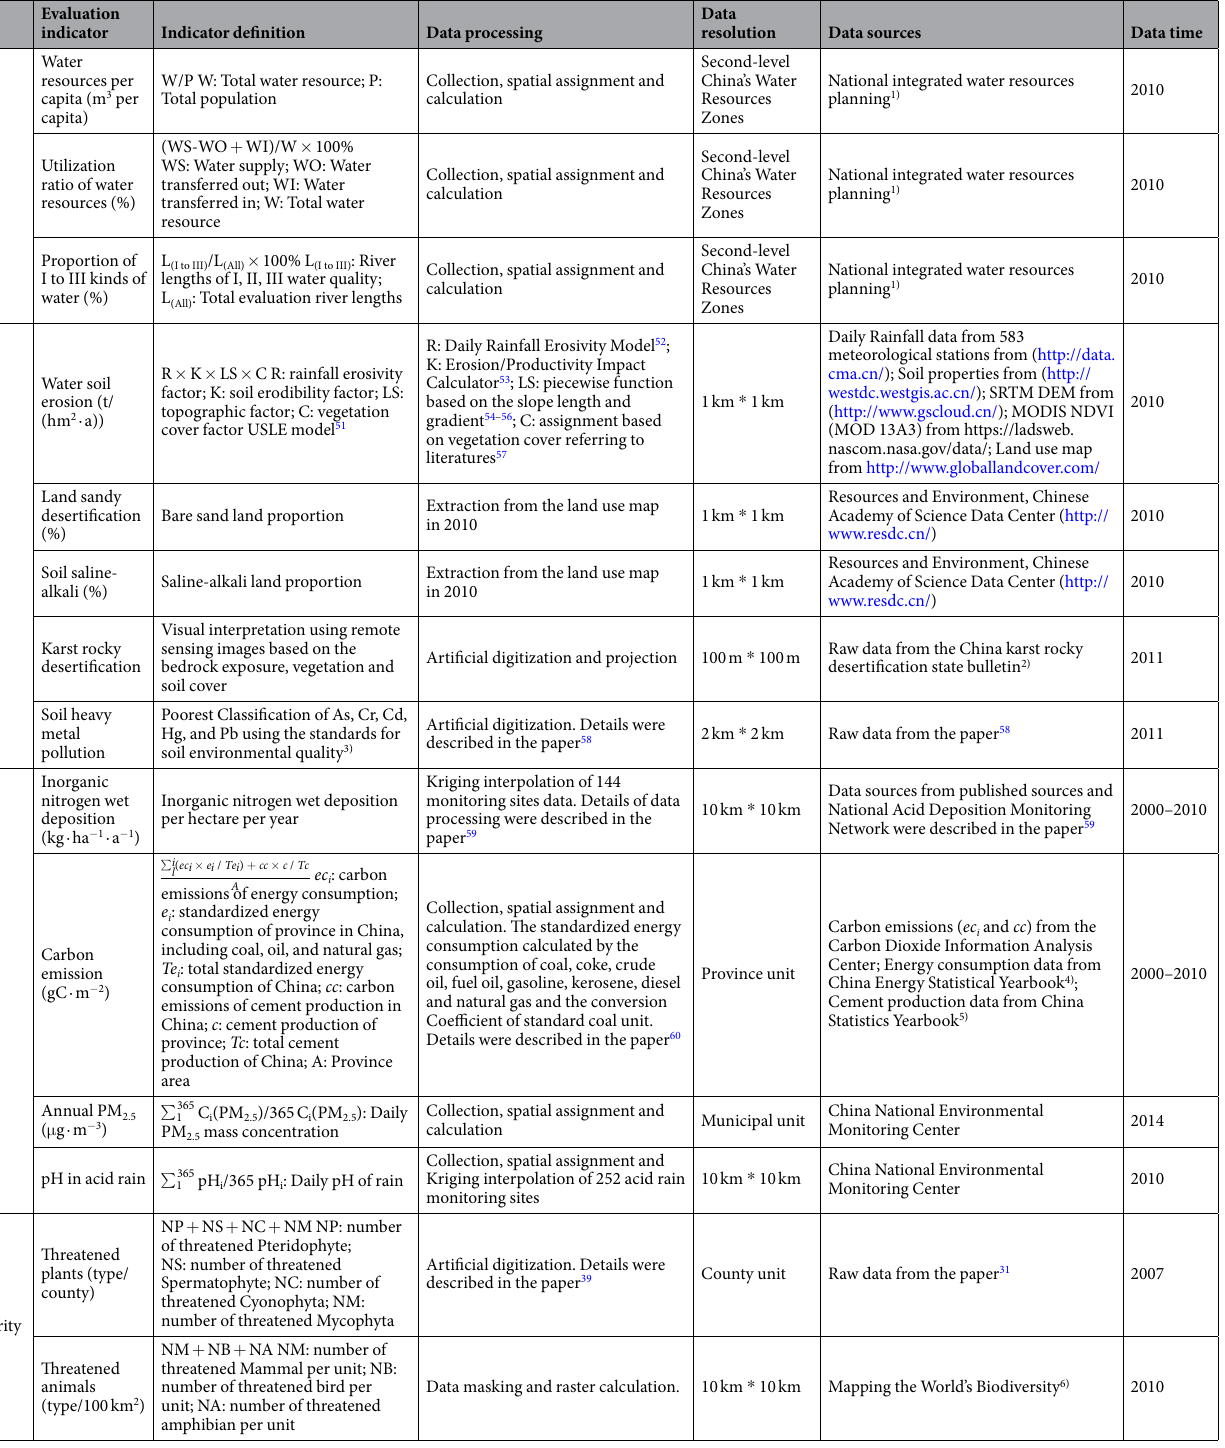
Table 2. Evaluation indicators of the ecological and environmental security. Note: 1) Ministry of